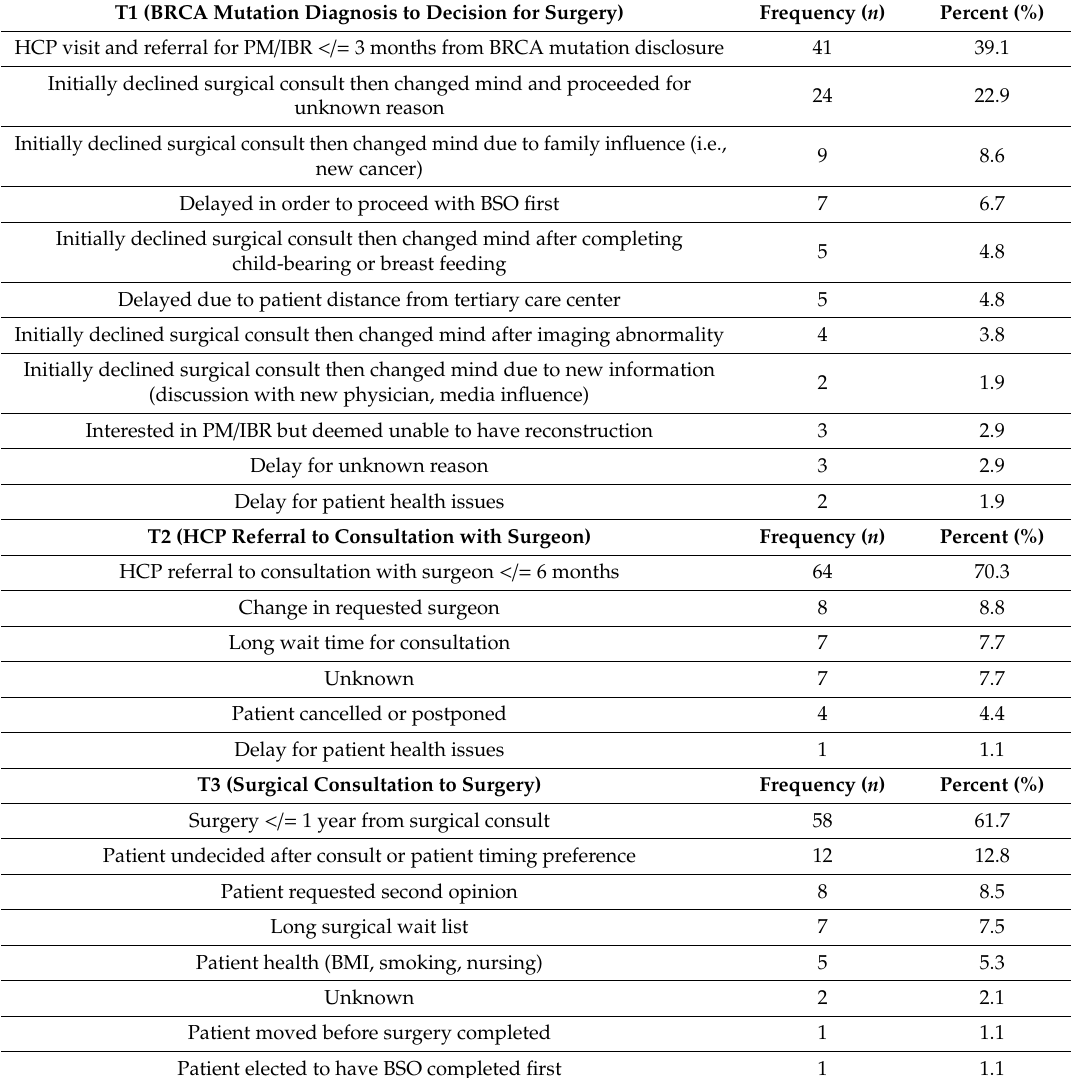
Table 4. Time Periods Leading to